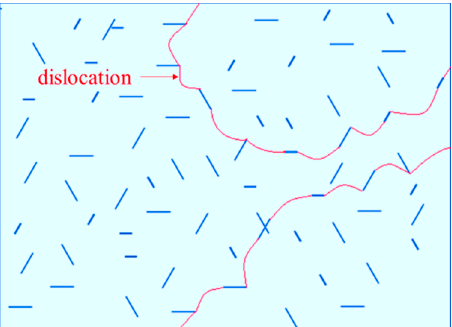
Figure 3. Schematic illustration of the dislocation interaction with unshearable plate-like particles, which are randomly distributed T 1 phases on the {111} plane and θ (cid:48) phases on the {001} plane, where long and thin lines represent T 1 phases and short and thick lines represent θ (cid:48)